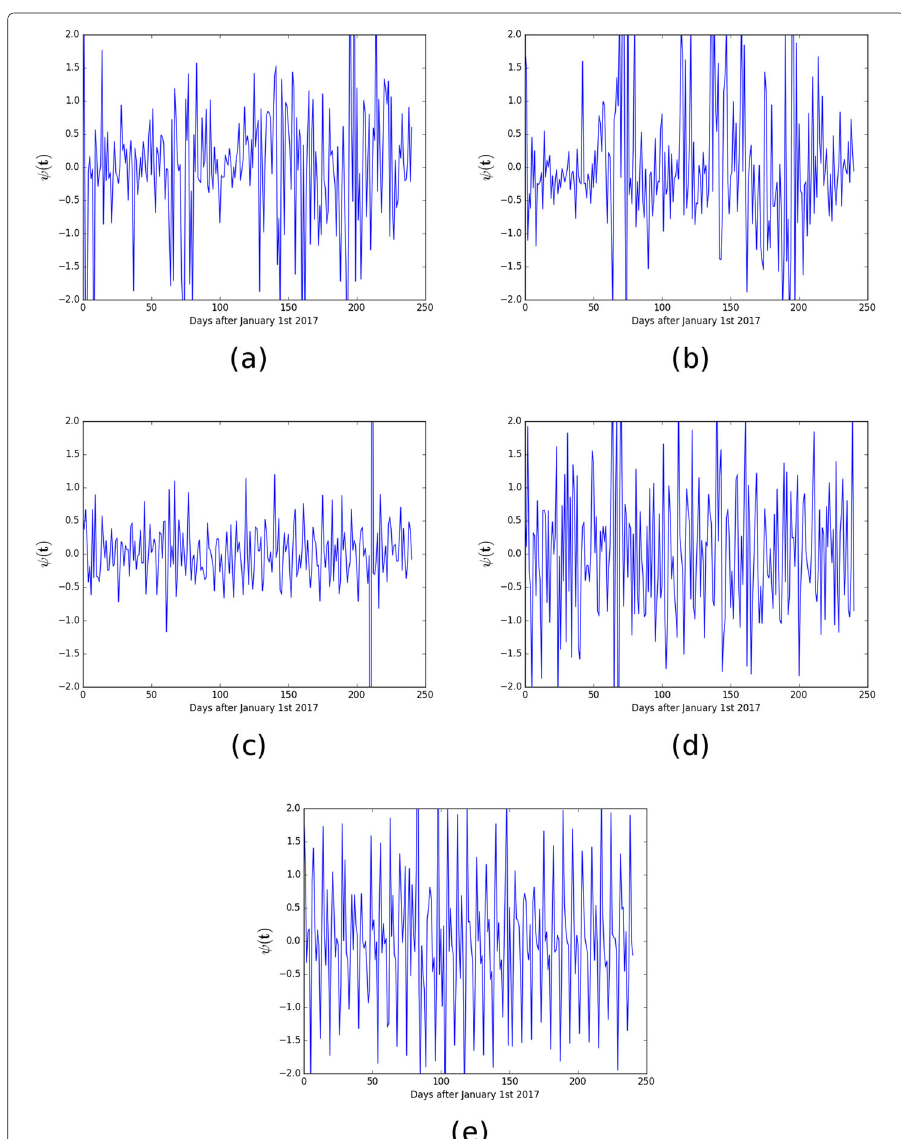
Fig. 8 The time series of noise variables for ( a ) Bitcoin, ( b ) Ethereum, ( c ) Twitter, ( d ) Reddit, and ( e ) GitHub sampled from 242